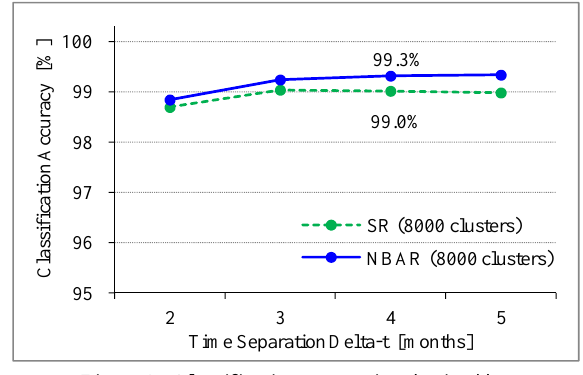
Figure 9. Classification accuracies obtained by time-domain co-occurrence matrix which is defined with 8000 spectral clusters.